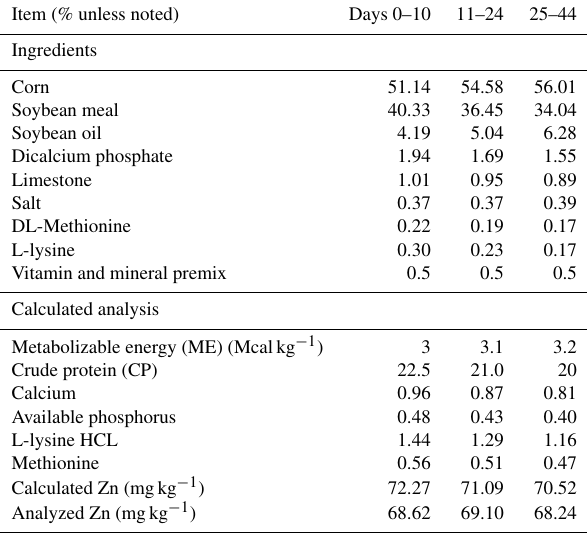
Table 1. Ingredient composition and analysis of the basal